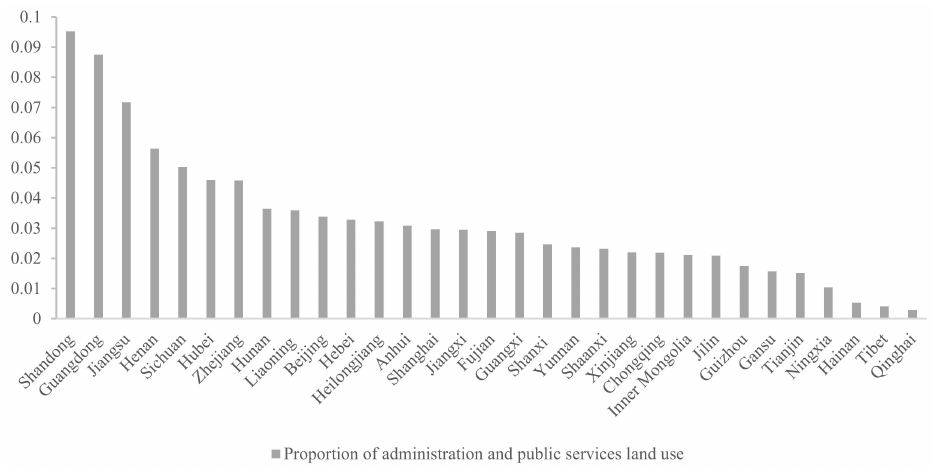
Figure 2. The proportion of administration and public service land use among Chinese provinces in 2017 (data source: Ministry of Housing and Urban-Rural Development of